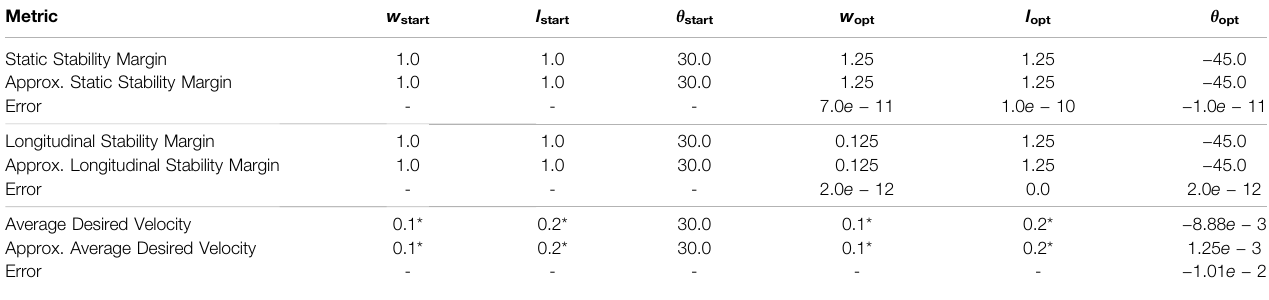
Longitudinal Stability